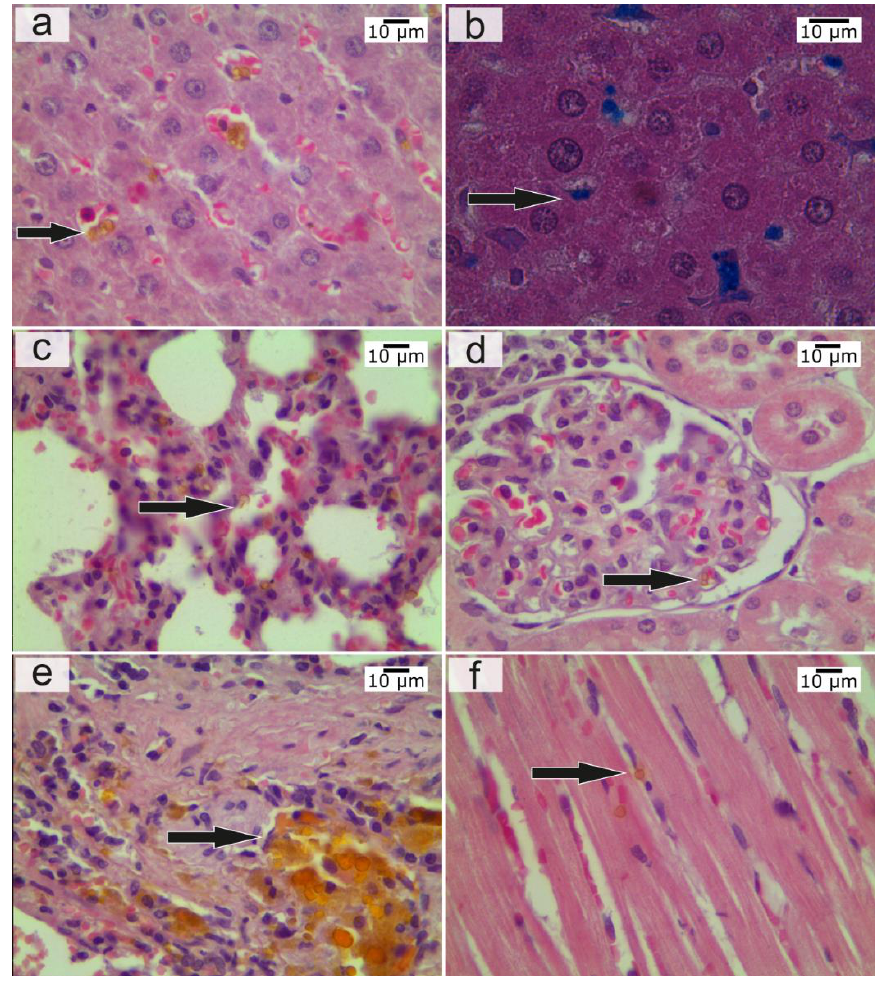
Figure 4. ( a ) Liver 4 h after intravenous injection (IVI) of the microcapsules — the conglomerates of